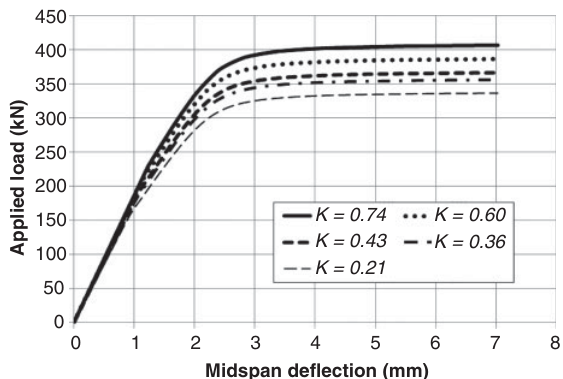
Fig. 9. Behaviour of girder CPG 1-A subjected to two concen- trated